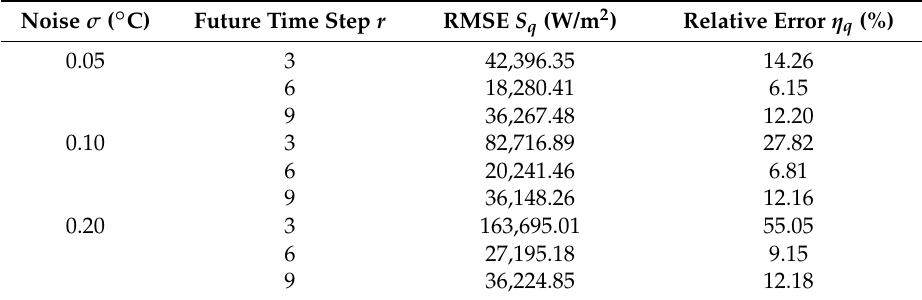
Figure 8. Inverse solution of heat flux with: ( a ) σ = 0.05 °C and r = 3, 6, 9; ( b ) σ = 0.10 °C and r = 3, 6, 9; and ( c ) σ = 0.20 °C and r = 3, 6, 9. Table 4. Error analysis for heat flux inversion with various values of future time step ( r) .